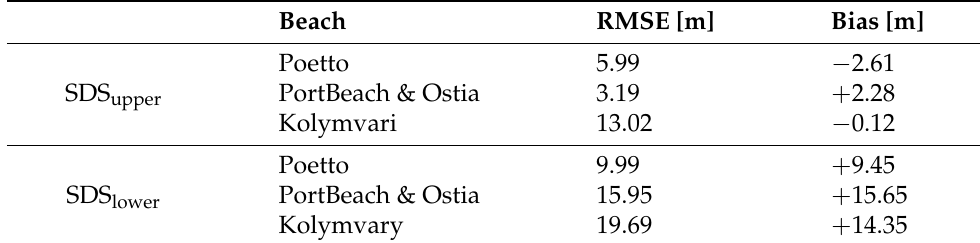
Table 7. Time-averaged RMSE and bias resulting from the GT shorelines and SDS upper and SDS lower comparison.